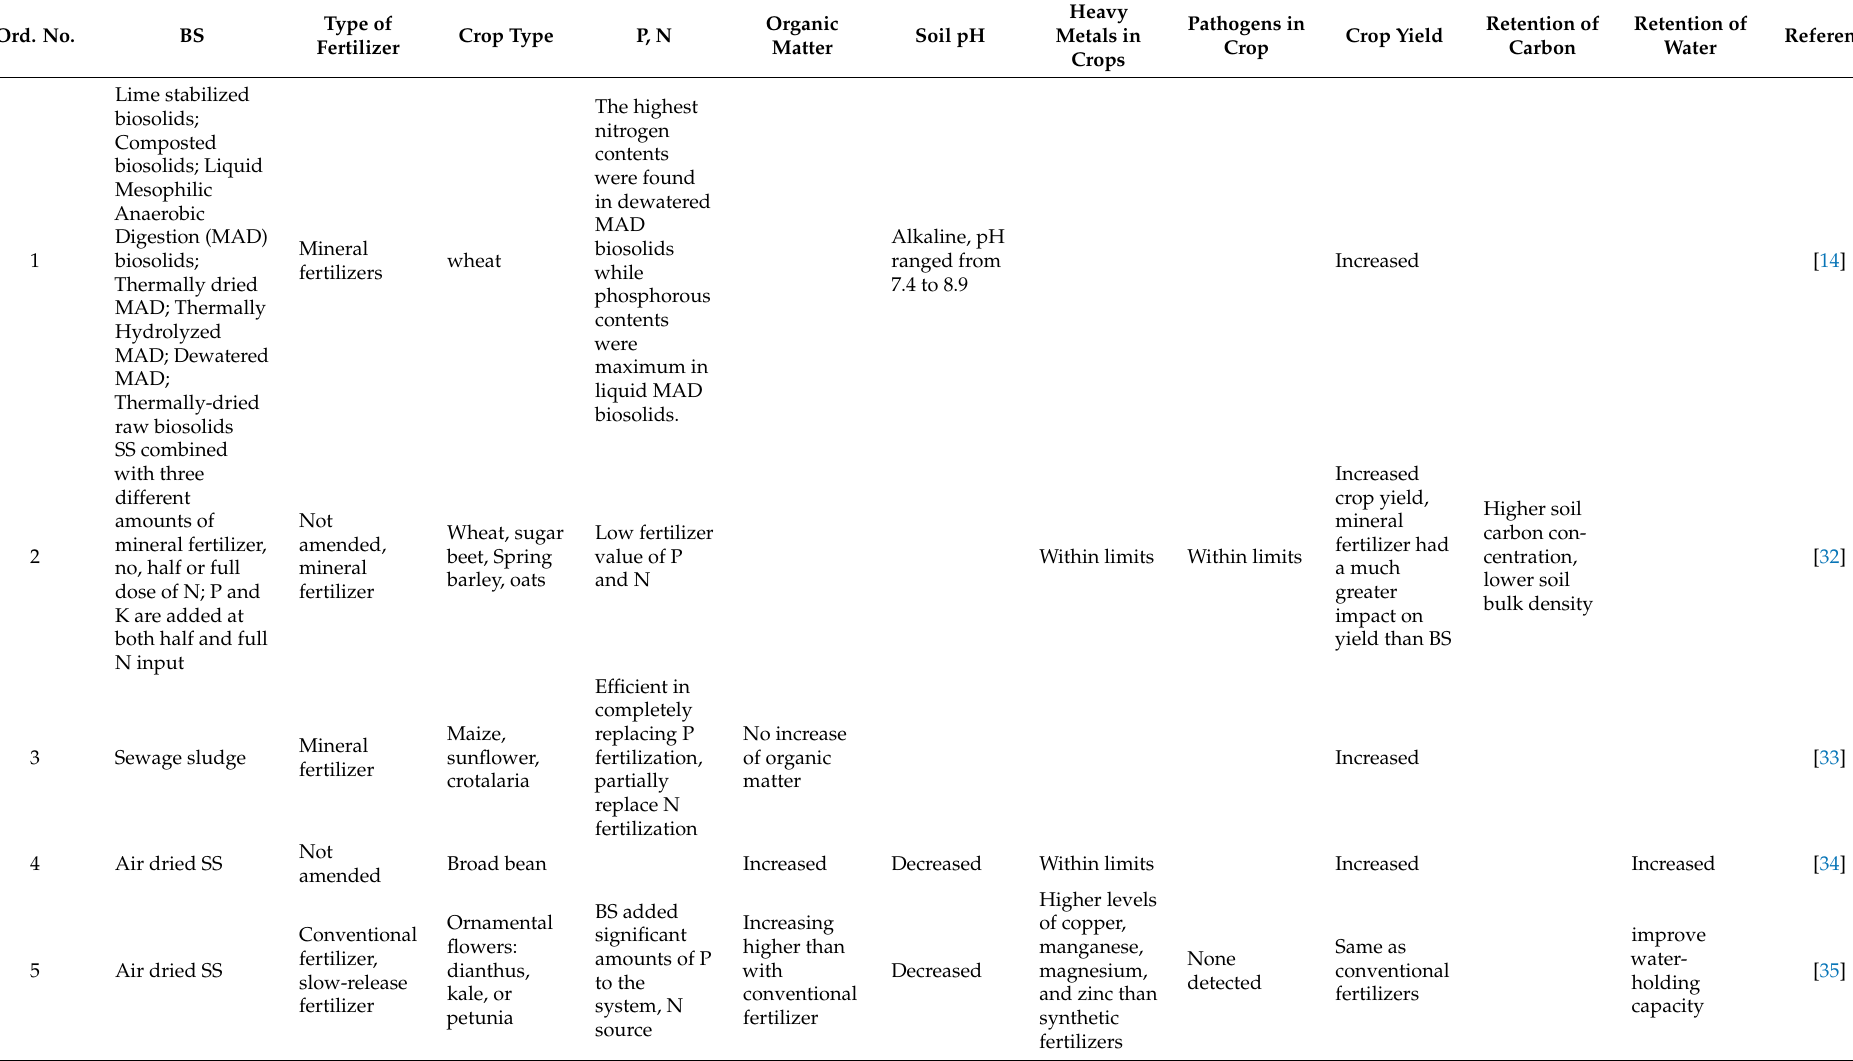
Table 2. Experimental investigations on biosolids’ (BS) use in agriculture and their effect on crop